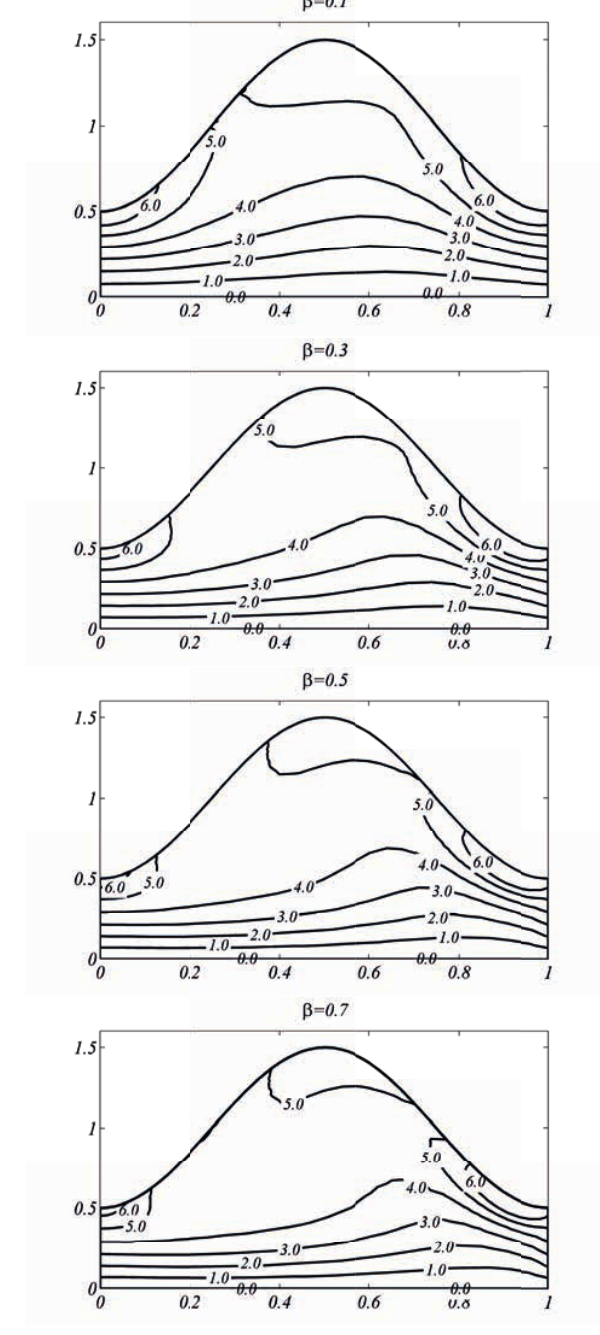
Fig. 11: Variation of streamlines against different values of α in wave frame with Re = 10, M = 2, β = 0.3, φ = 0.5, Q = 1.3 .